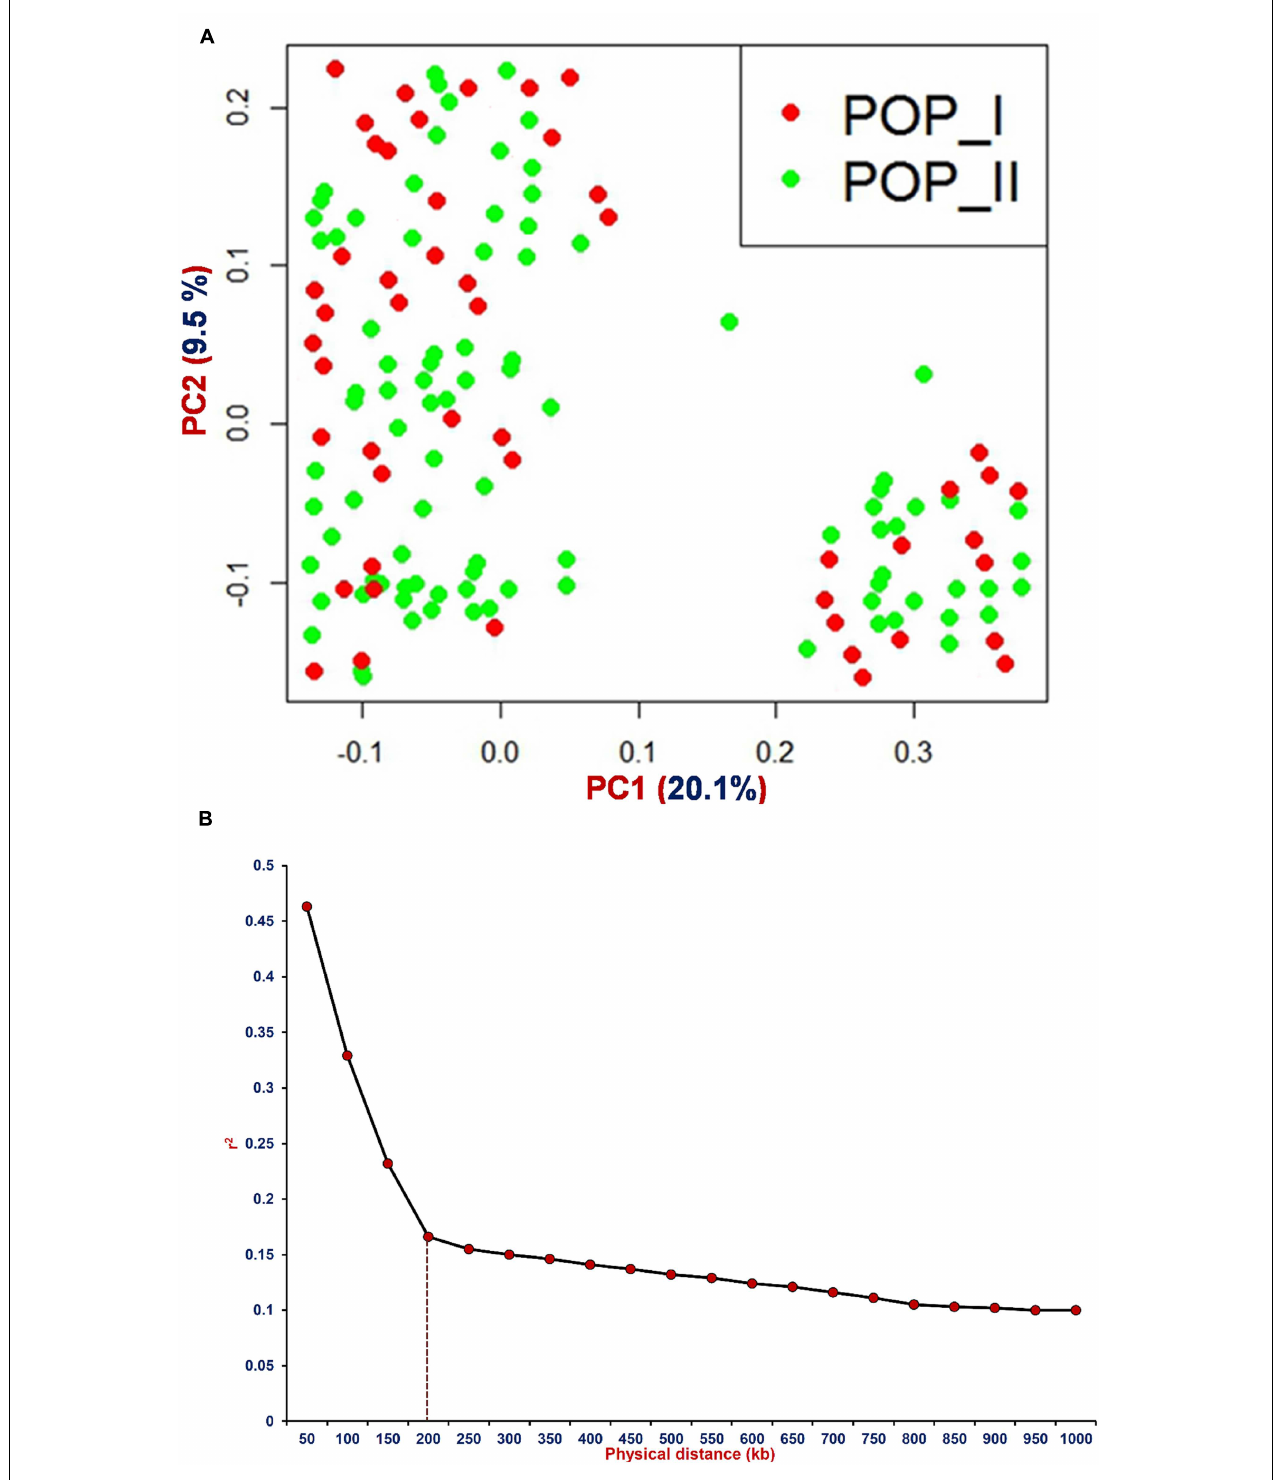
FIGURE 2 | The determination of (A) principal component analysis (PCA) employing 16376 genome-wide GBS-SNPs classified 336 desi and kabuli chickpea accessions into two major populations [POP I (red) and POP II (green)]. In PCA, the PC1 and PC2 explained 20.1 and 9.5% of the total variance, respectively. (B) LD decay (mean r 2 ) measured in a population of 336 chickpea accessions using 14115 chromosome-wise physically mapped SNPs. The plotted curved line denotes the average r 2 values among SNPs spaced with uniform 50 kb physical intervals from 0 to 1000 kb across kabuli chromosomes.